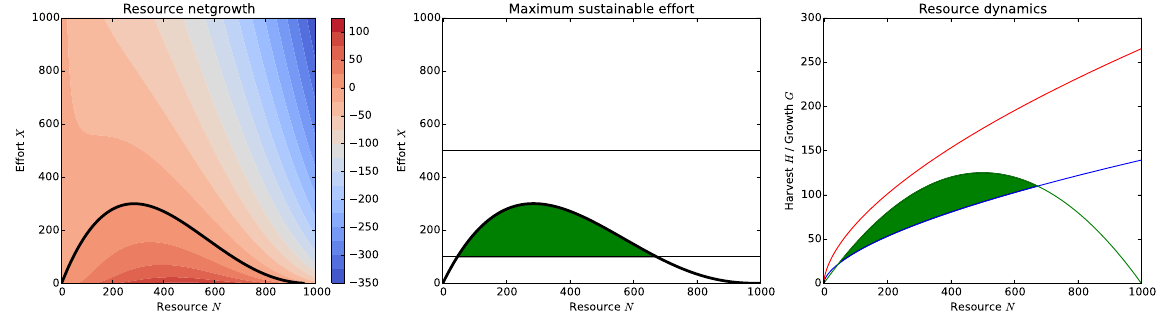
Figure 2. Suiatainable harvest levels. ( a ) Contour plot of resource net growth G − H ; the black line indicates X maxsustainable , efforts above this line produce negative net growth. ( b ) Resource net growth with effort limits (thin black lines); the green shaded area emphasises sustainable effort levels at which the net growth G − H ≥ 0. ( c ) Resource dynamics with positive net growth resulting from the sustainable harvest efforts described in Fig. 2b indicated by the green shaded